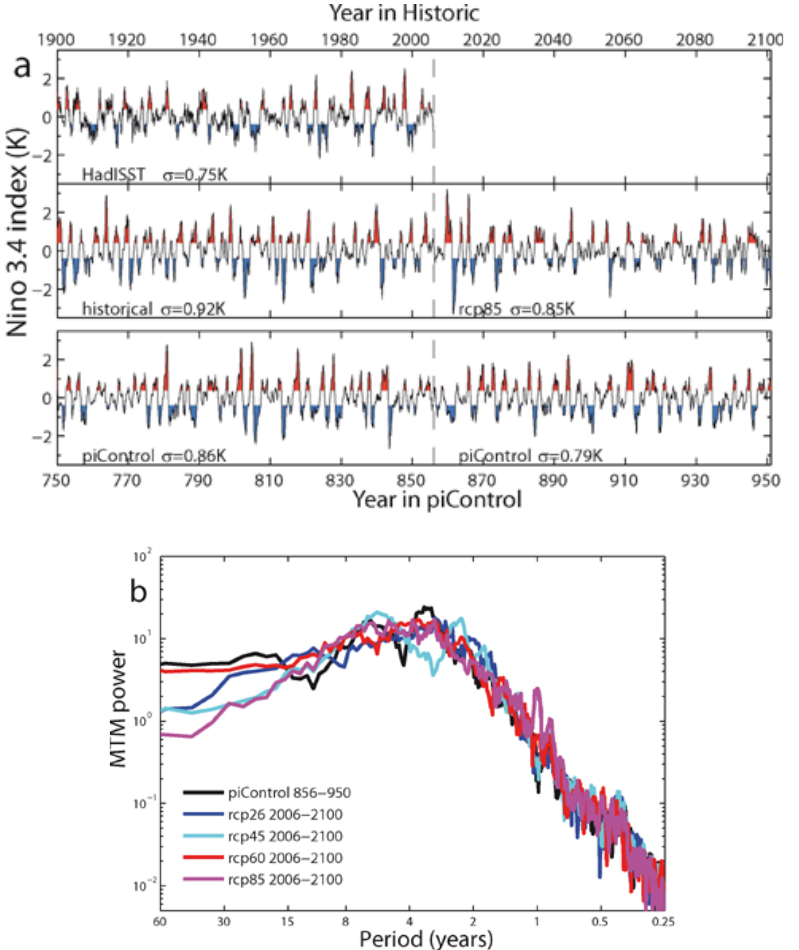
Fig. 16. Panel (a) shows time series of detrended monthly SST anomalies of the NINO3.4 region (5 ◦ S–5 ◦ N, 170–120 ◦ W). The anomalies are found by subtracting the monthly means for the whole time series. Red (blue) colours indicate that anomalies are larger (smaller) than +0.4K ( − 0 . 4K), see Trenberth (1997) for recommendations. Upper time series shows Hadley Centre Sea Ice and Sea Surface Temperature data set (HadISST; Rayner et al., 2003) for years 1900–2005; middle time series consist of NorESM1-M Historic1 for years 1900–2005 continued with NorESM1-M RCP8.5 for years 2006–2100; lower time series displays NorESM1-M piControl for years 750–950. Panel (b) shows power spectra of the NINO3.4 index (the SST anomalies normalised with its standard deviation) using the multi-taper method of Ghil et al. (2002) with resolution p = 4 and number of tapers t = 7. Data sources are NorESM1-M piControl years 856–950 (black),